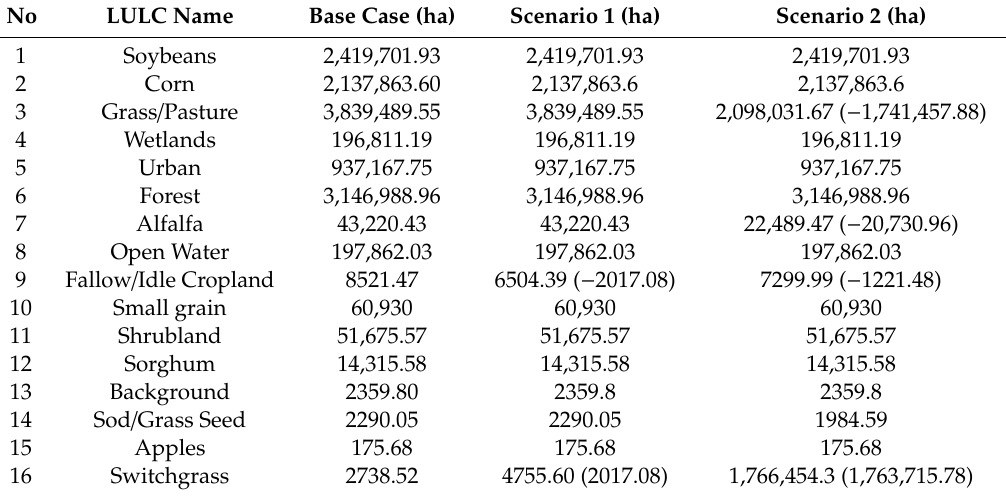
Table 3. LULC class changes in di ff erent scenarios. Food crops are una ff ected and non-food uses are